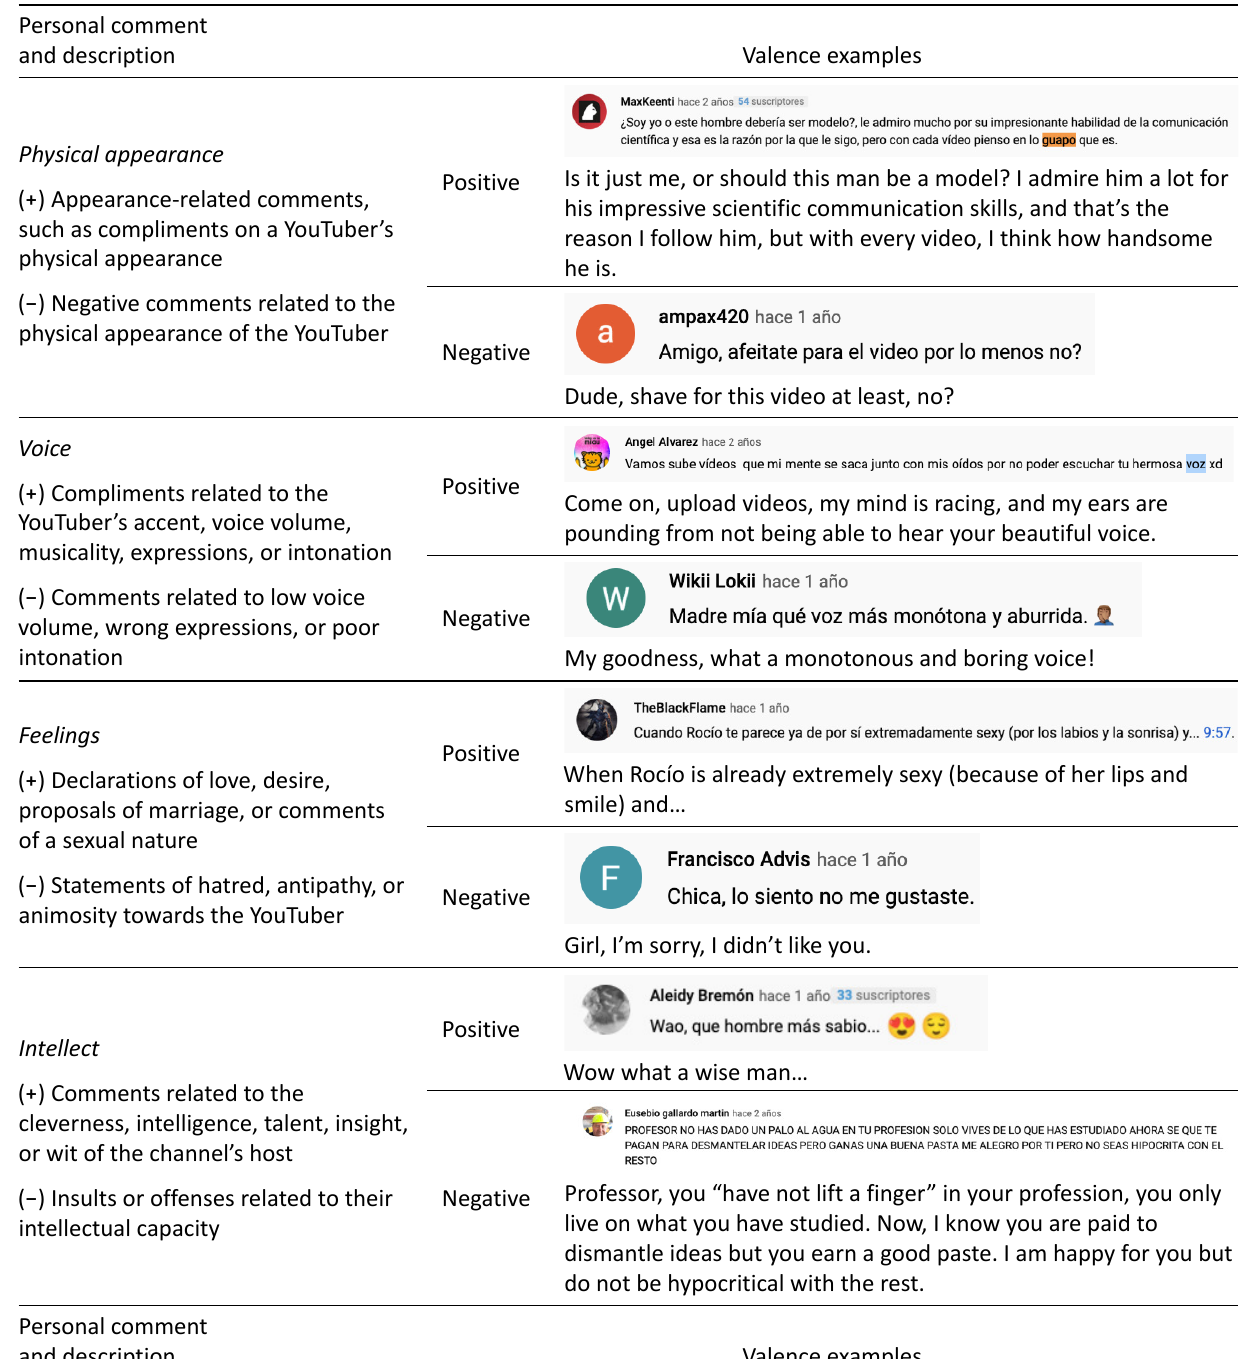
Table 4. Personal comments and valences identified in the science popularisation videos disseminated through YouTube